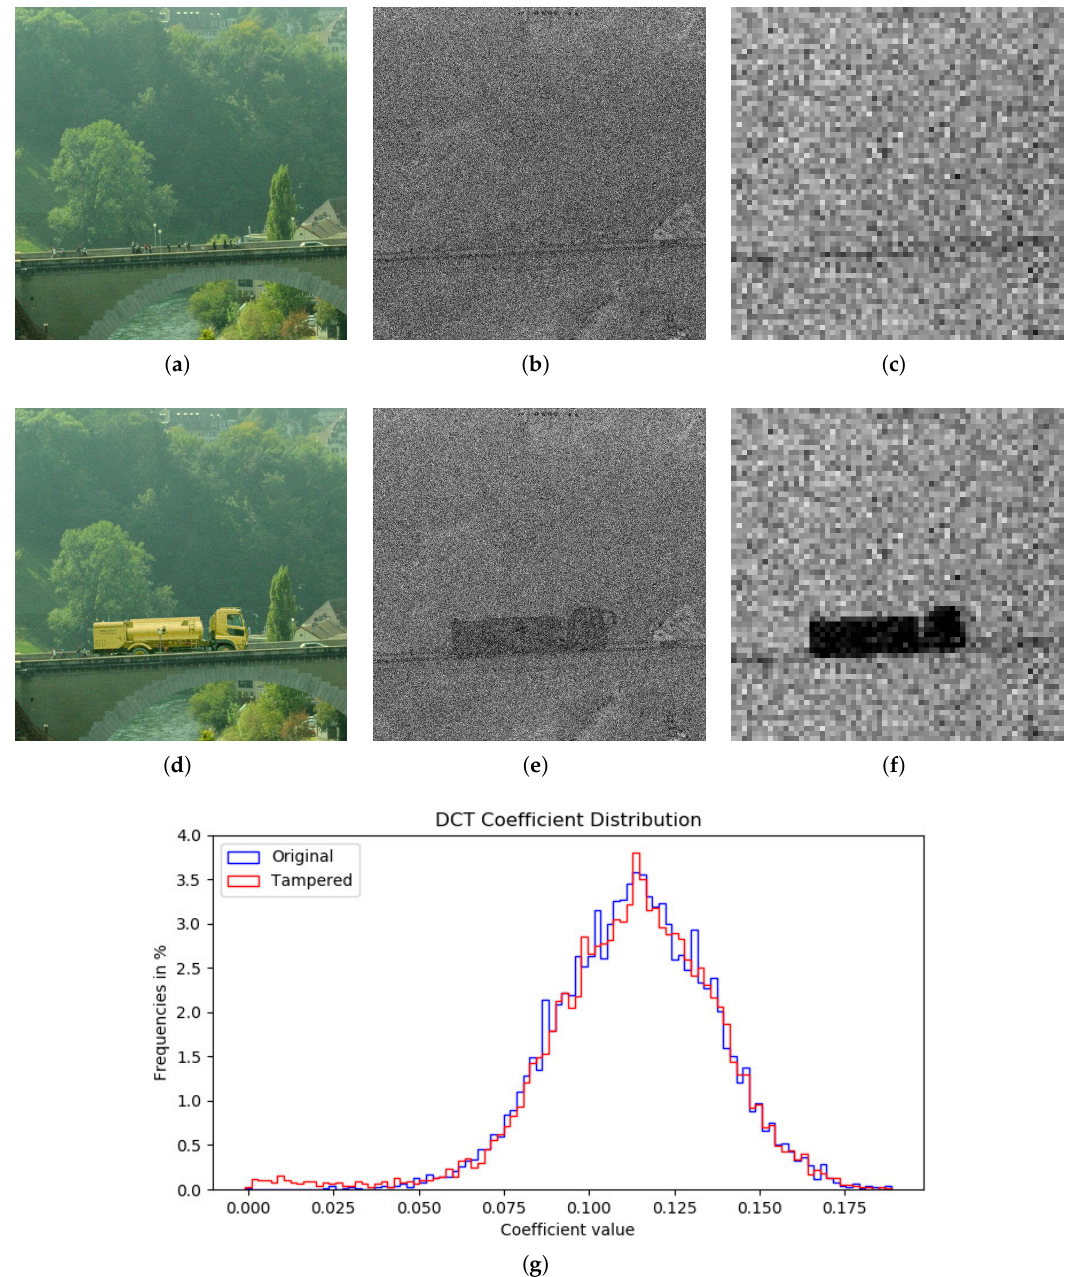
Figure 10. Probability maps and heatmaps in black and white of ( a ) original image vs. ( d ) tampered image. Subimages at ( b , e ) correspond to their probability map and ( c , f ) show a heatmap for the result of applying DCT on blocks of size 16. Histogram in ( g ) shows the distribution of DCT coefficients for original and tampered images. A broader left tail can be seen for the tampered one, corresponding to low values and exhibiting a possible